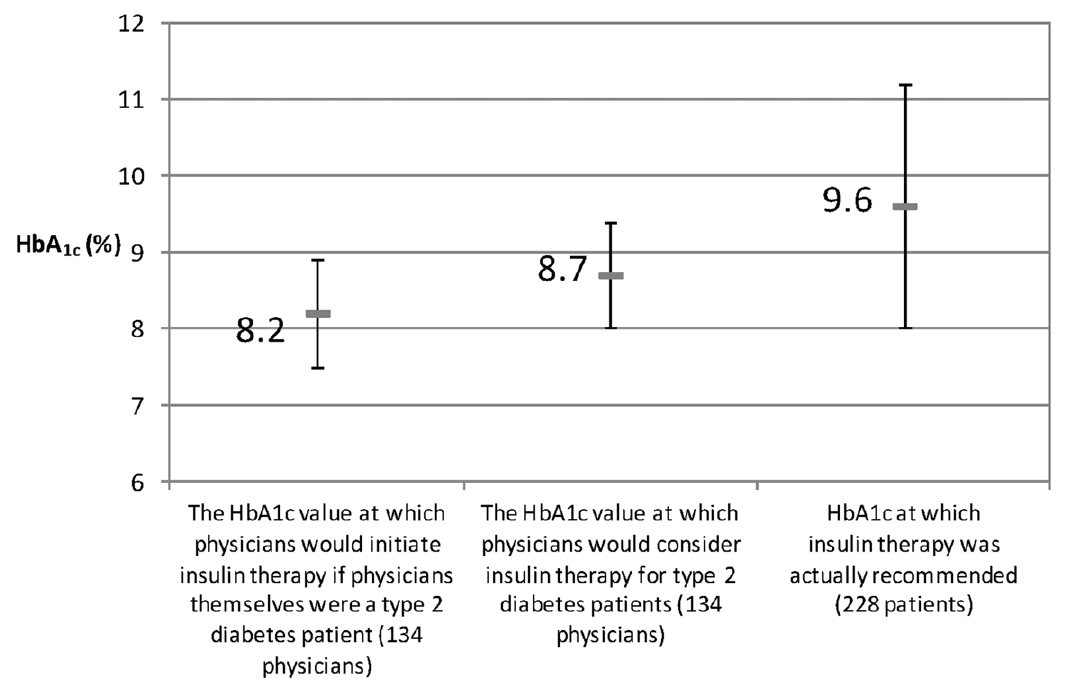
Figure 2. Gap between considered and actual recommended level of HbA1c. HbA 1c level at which insulin therapy would be recommended was compared to actual level at which insulin therapy was recommended (mean 6 SD).